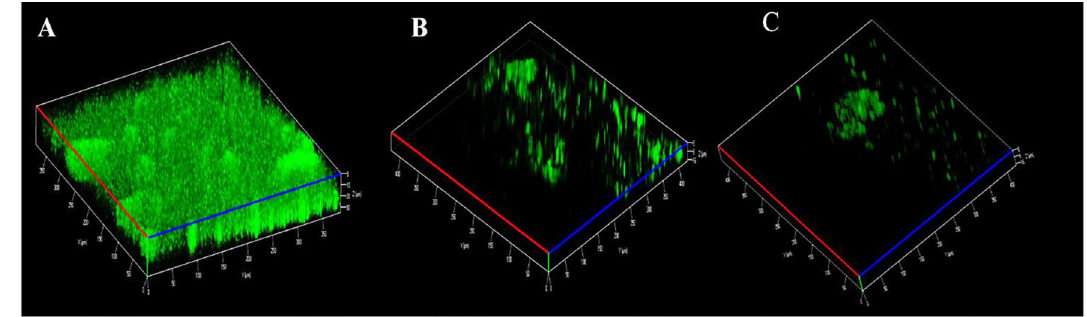
Figure 4. CLSM microscopic analyses of S. marcescens biofilm formation. ( A ) Control untreated biofilm. ( B,C ) showed disintegration of S. marcescens biofilm formation compared to their untreated controls.